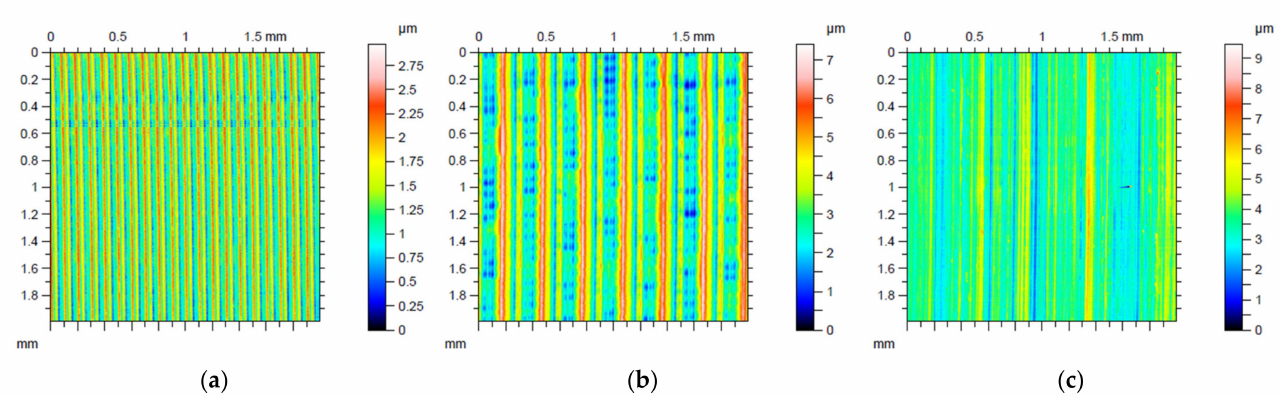
Figure A1. Surface topography of the ( a ) hard turned ( f = 0.1) surface—M1 ( b ) hard turned ( f = 0.3) surface—M2 ( c ) ground